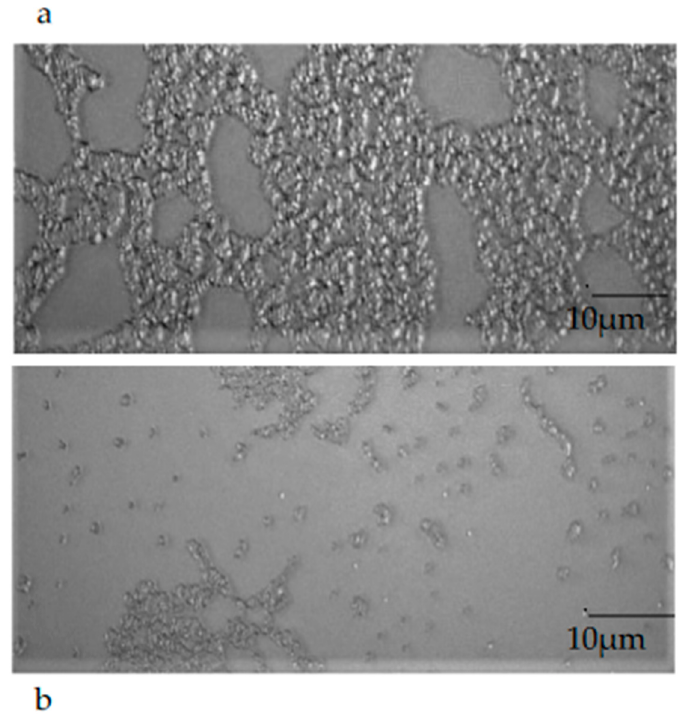
Figure 8. An example of the mature biofilm structure of a Staphylococcus aureus O strain in the absence ( a ) and in the presence ( b ) of Melaleuca alternifolia essential oil (TTO).